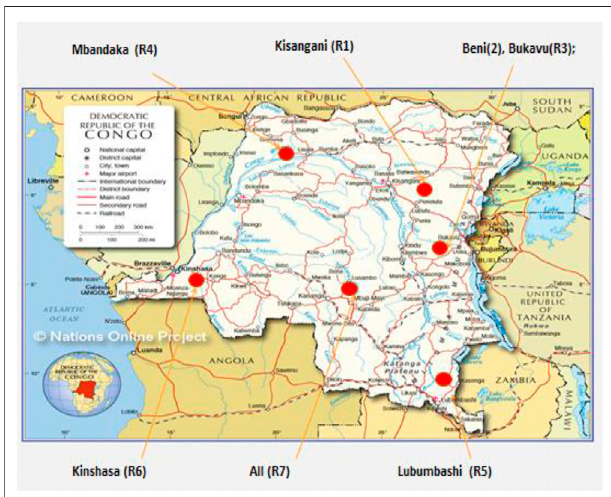
FIGURE 3 | Study sites in the Democratic Republic of